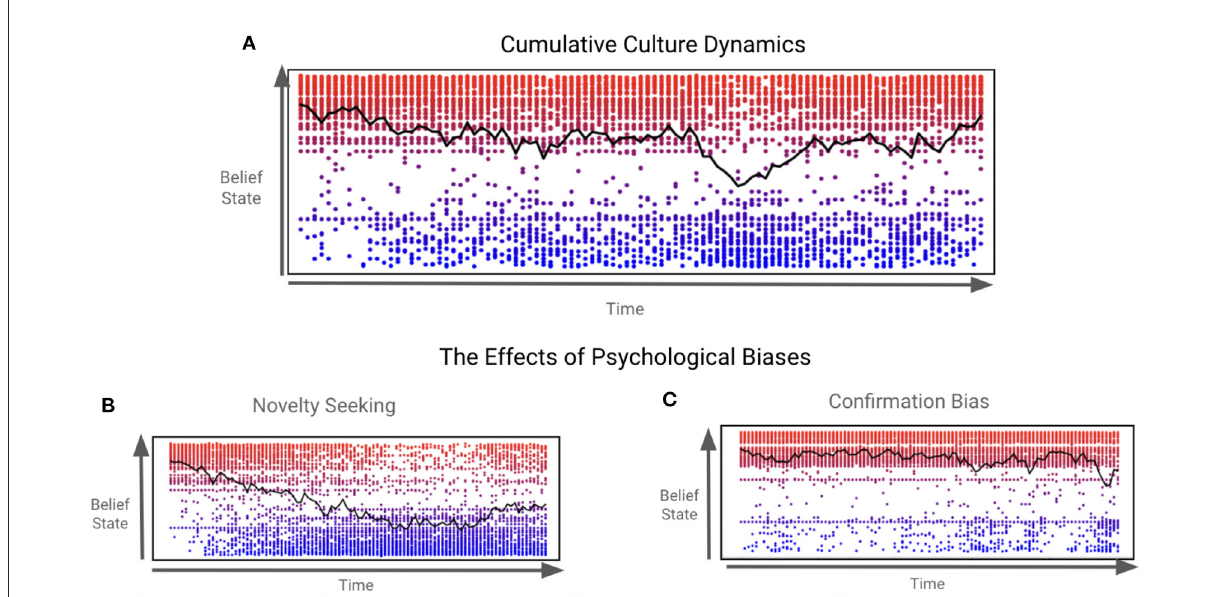
FIGURE9 The emergence of cumulative culture. This Figure and its caption were adapted from an open-source preprint of a conference paper, with permission of the authors (Figure 3 of Kastel and Hesp, 2021). These plots depict the evolution of population-averaged support (black line) with regards to the idea that represents the initial status quo (top indicates 100% support, bottom indicates 0% support) over time (horizontal axes) along with individual core beliefs (shown in the underlying scatter plot, explained below) in three simulations, for which only the relative size of the subgroup with high confirmation bias was modulated [ (A) : 5%, (B) : 15%; (C) : 85%]. The underlying scatter plots indicate the core beliefs of individual agents by means of their vertical location as well, with a color scale for additional clarity (red indicating maximal support for the status quo, blue maximal support for the novel idea). (A) Simulation of a Cumulative Culture: In this reference simulation, half of all agents are parameterized with high confirmation bias. When a divergent belief state (blue) is introduced to the status quo population (red) at the first time step, it spreads through it via agents in dialogue that cumulatively change the belief structure within the population. Notably, the introduction of a divergent belief seems to split the population into two subgroups: those supporting the new idea, and those adhering to the previous